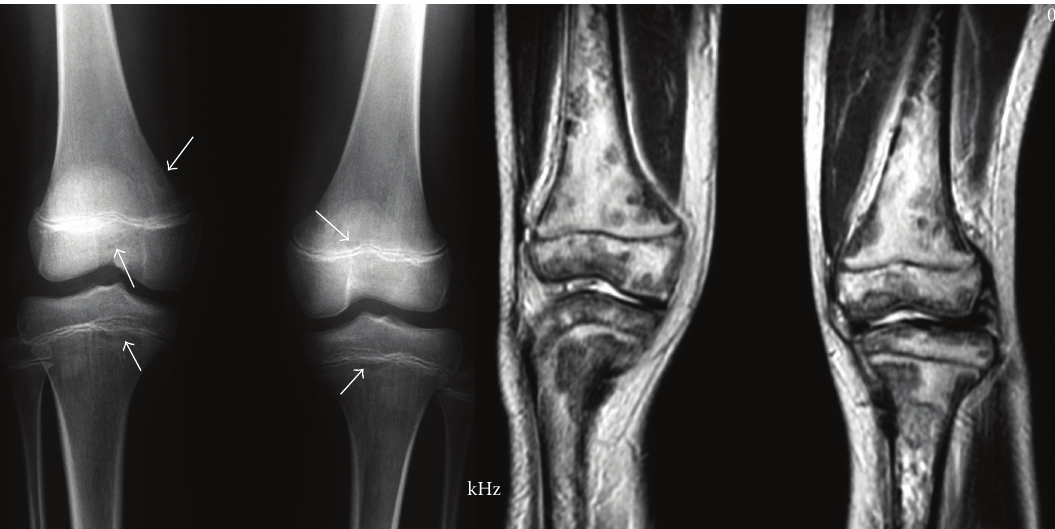
Figure 1: AP and MR image of both knees. AP film of both knees shows osteolytic lesions as well-marginated lucencies in femurs and tibias. Sagittal T2-weighted MR image of both knees shows multiple nodular low-density